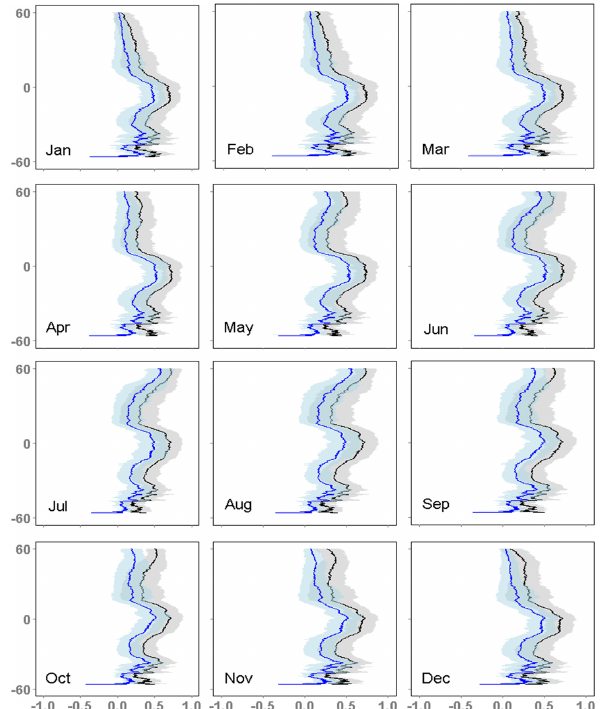
Figure 7. The latitudinal mean (solid line) and standard deviation (ribbon) of the Global Inventory Modeling and Mapping Studies normalized difference vegetation index version 3 (blue) and Vegeta- tion Index and Phenology Lab version 3 normalized difference veg- etation index (black) over 30 years. Values are shown from 60 ◦ N– 60 ◦